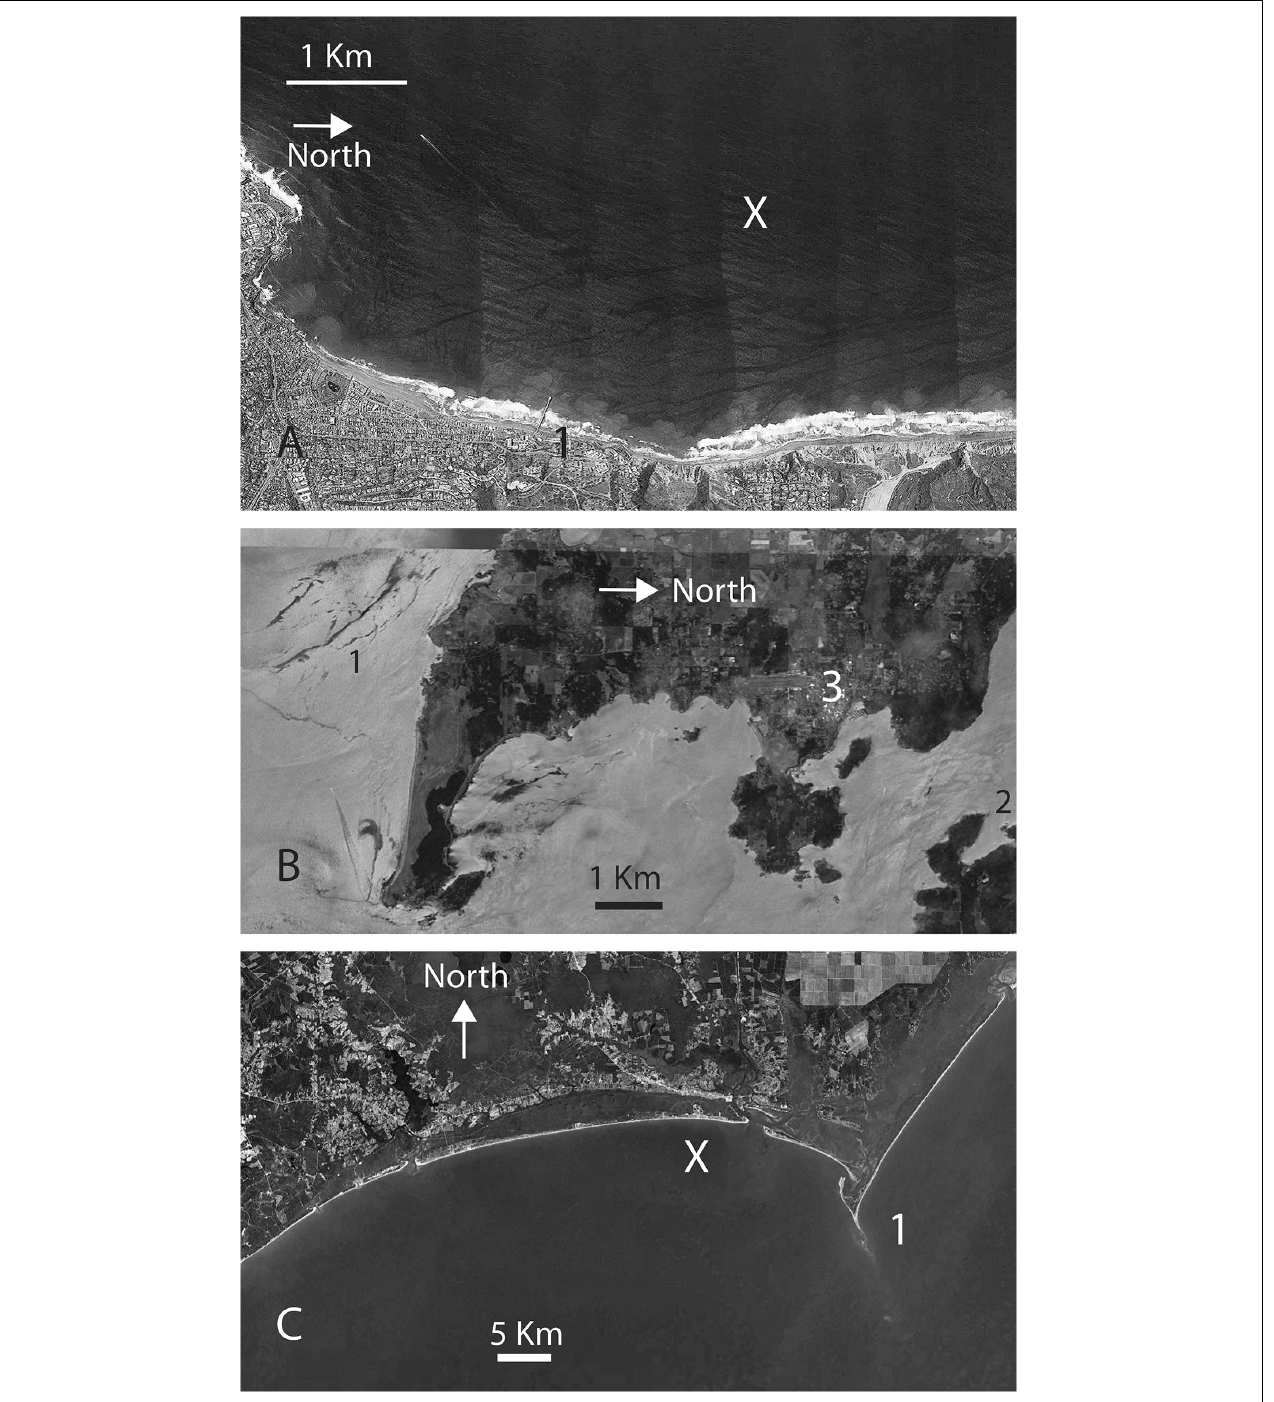
FIGURE 4 | Areas where internal wave convergences were sampled. (A) La Jolla, California. The pier at “1” is located at the Scripps Institution of Oceanography, University of California, San Diego (32.87 N, 117.25 W). Internal wave convergences were sampled within about 3 km of X. The slightly darker streaks landward and to the right of X are internal wave convergences. (B) Sample sites within the San Juan Archipelago, Washington State. B1) This sample site was offshore Cattle Point. The linear dark smudges in the picture are internal wave convergences. B2) Indicates Park Bay where we sampled internal wave convergences and ran an initial experiment on the capacity of internal waves to differentially transport material to shore. The town of Friday Harbor is indicated by 3 (48.53 N, 123.02 W) (C) Cape Lookout Bight with Cape Lookout indicated by the “1” (34.59 N, 76.54 W). A sand bars extends seaward from the Cape most of the way across the shelf. To the south and outside the image area is Cape Fear, which also has an attached sand bar, which extends across the shelf. Sampling was carried out within about 3 km of X. Images are visible light aerial photographs from Google Earth.